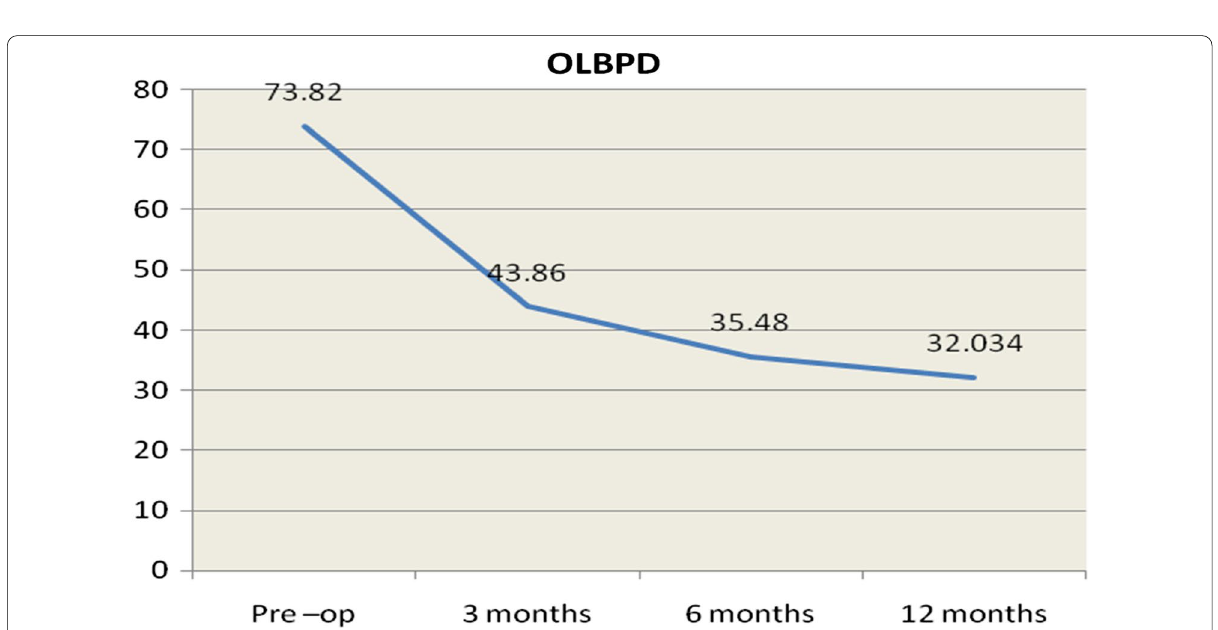
Fig. 2 Line diagram showing the improvement in the OLBPD (Oswestry Low Back Pain) from preoperative period to postoperative